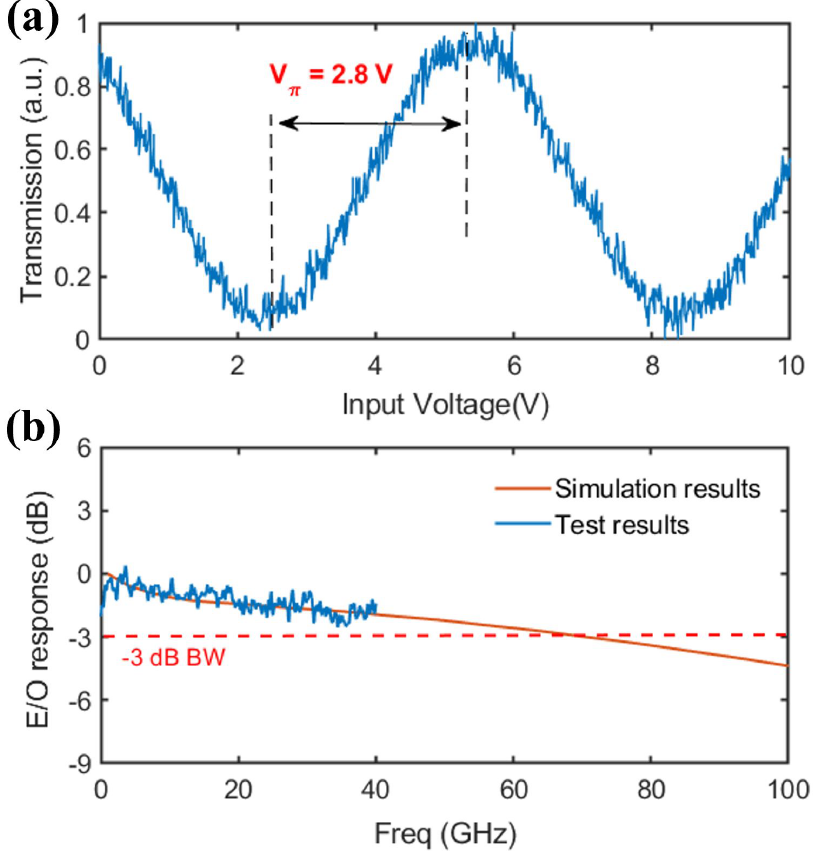
Figure 4. ( a ) Measured transmission spectrum under a 100-kHz triangular wave voltage sweep with an amplitude of 10 V. ( b ) Measured and simulated E-O response as a function of